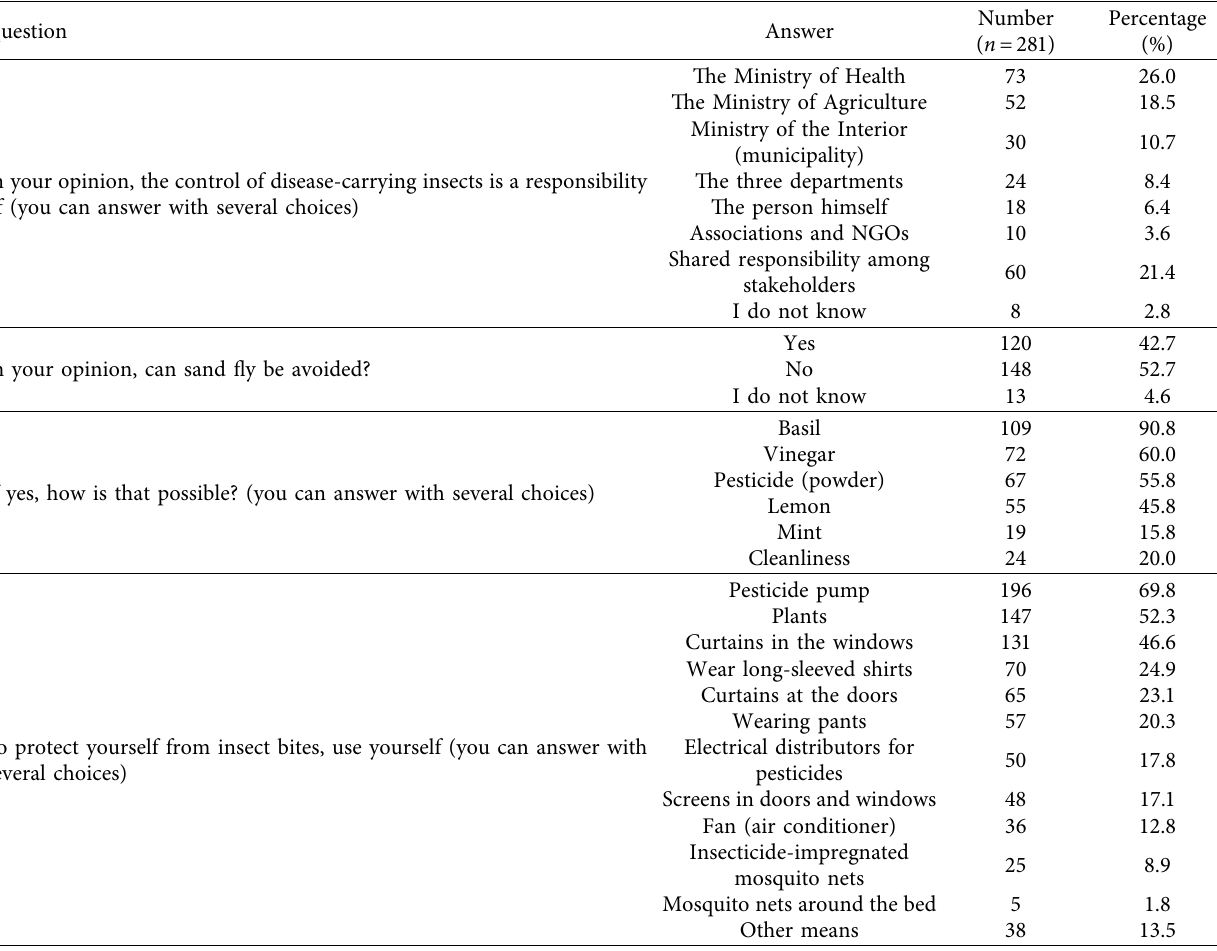
Table 5: Measures used by citizens to protect themselves against insect